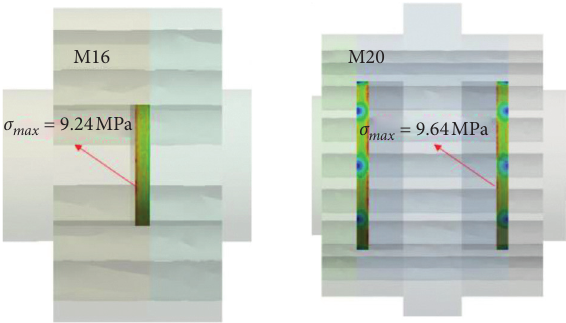
Figure 16: Equivalent stress distribution of the contact surfaces with interference fits.